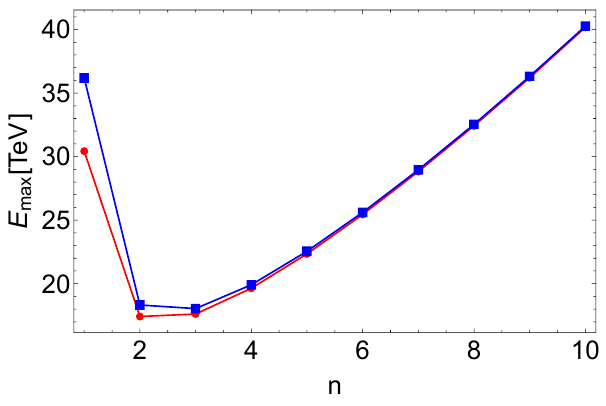
Figure 9 . The unitarity-violating scale as a function on n for γ ± h n → Z T ∓ h n (blue),